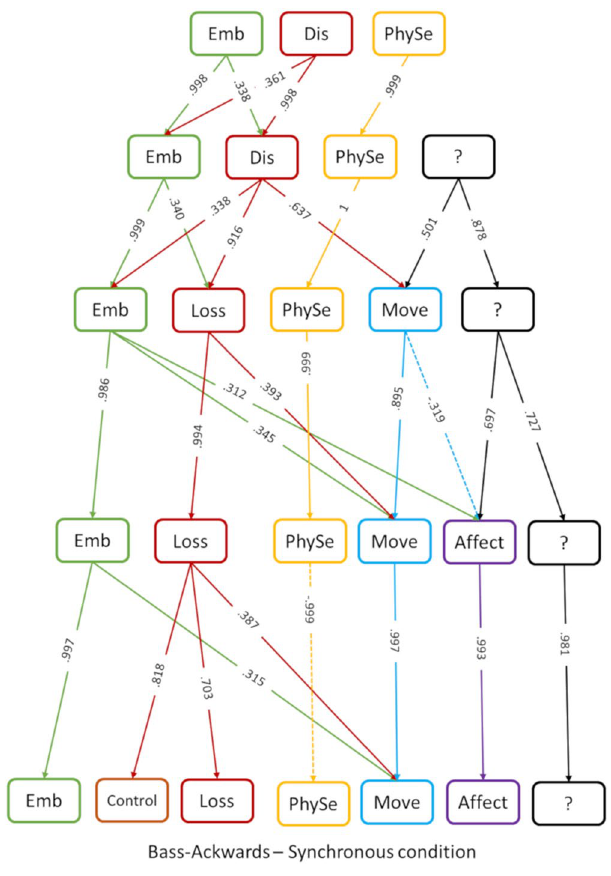
Figure 2. Results of the Bass–Ackwards procedure on the items after synchronous stimulation. The correlations between the components of different solutions are represented. Negative correlations are reported with dash lines, while positive correlations are in solid lines. Components’ names are abbreviated: Emb embodiment, Dis disembodiment, PhySe physical sensations, Loss loss-of-own-hand, Move movement, Affect affect towards the general experience, Control control on own hand actions, ? undefined component. Colours are used to help the readability of the graph.